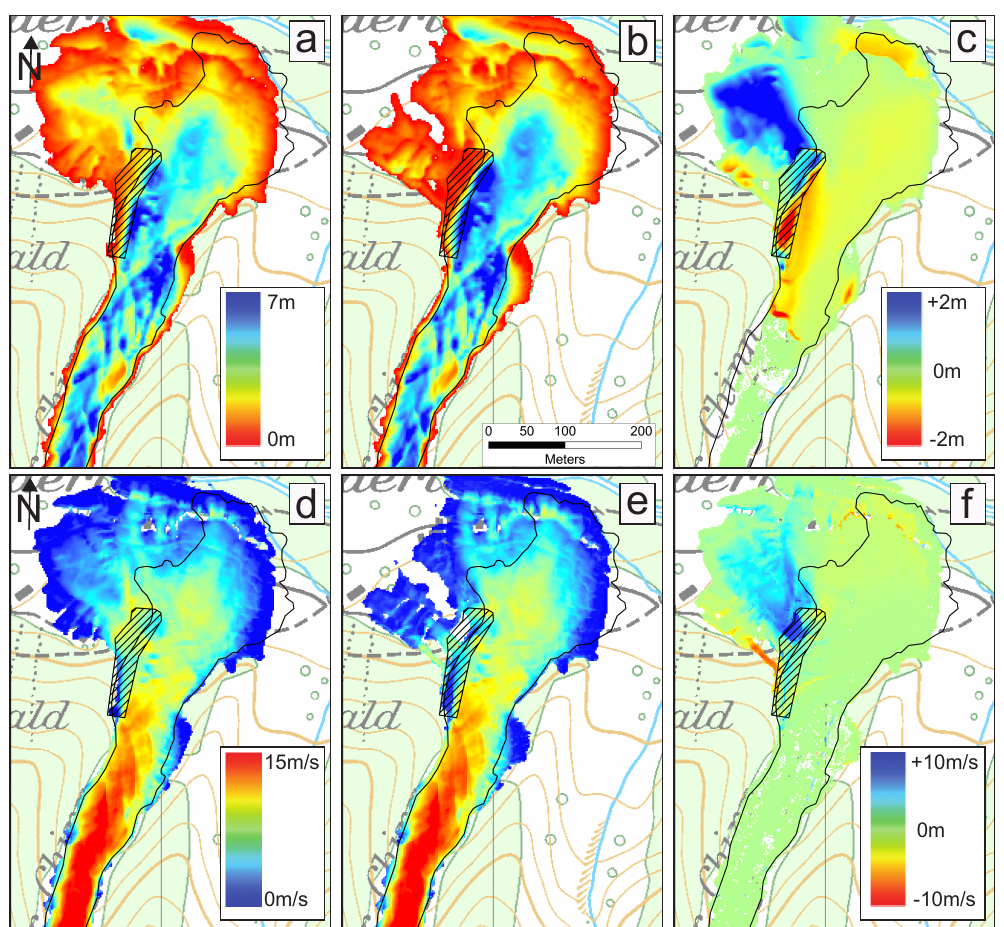
Fig. 17. Comparison between simulations ] 2, without dam, and ] 1, with dam. Panels show: maximum flow depth from simulation ] 2 (a) ; maximum flow depth from simulation ] 1 (b) ; difference between (a) and (b) (c) ; maximum velocity from simulation ] 2 (d) ; maximum velocity from simulation ] 1 (e) ; difference between (d) and (e) (f)